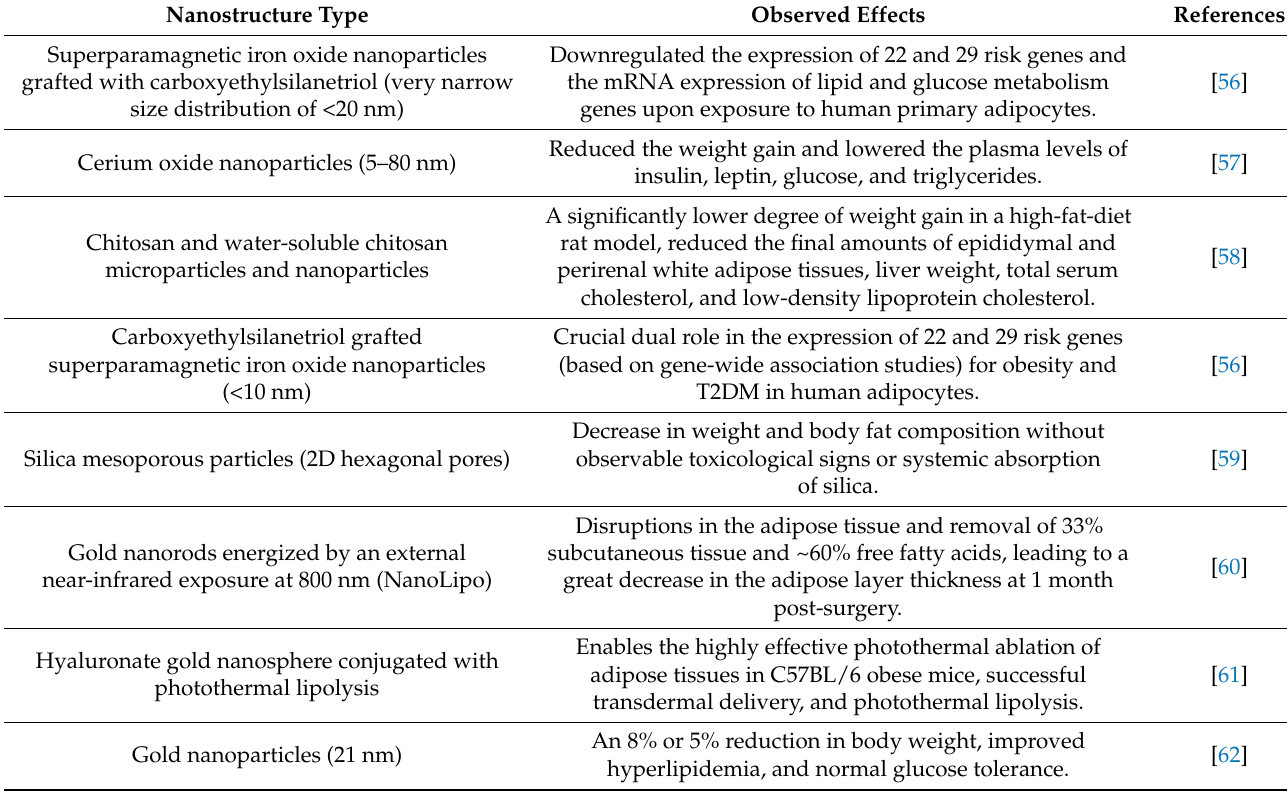
Table 3. Nanostructures and their therapeutic roles in the management of